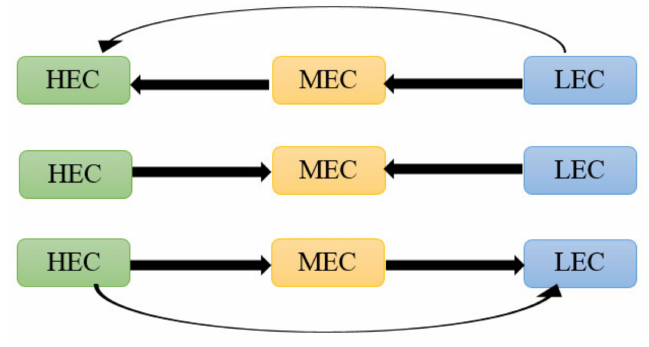
Figure 1. Behavior modification cases.